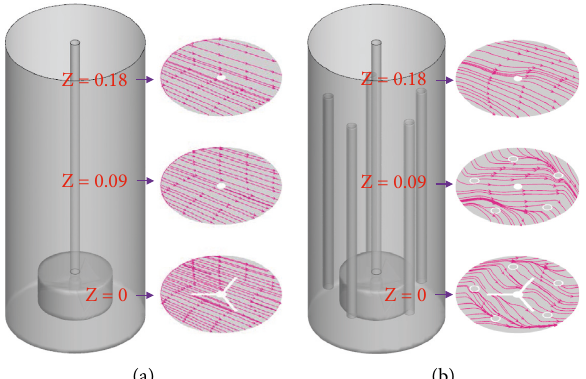
Figure 7: The distribution of fluid flow traces on different horizontal planes in the tank. (a) Traditional stirred tank. (b) Dynamicstatic combined stirred tank.